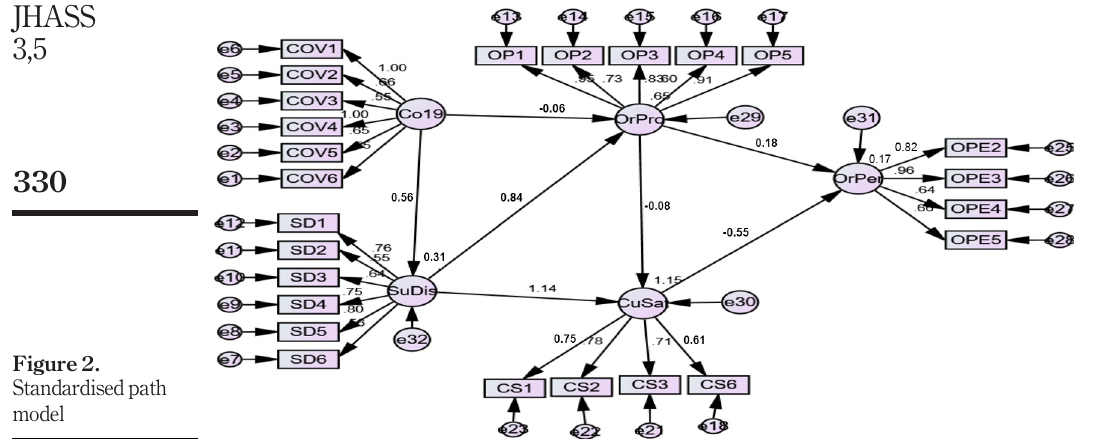
Figure 2. Standardised path